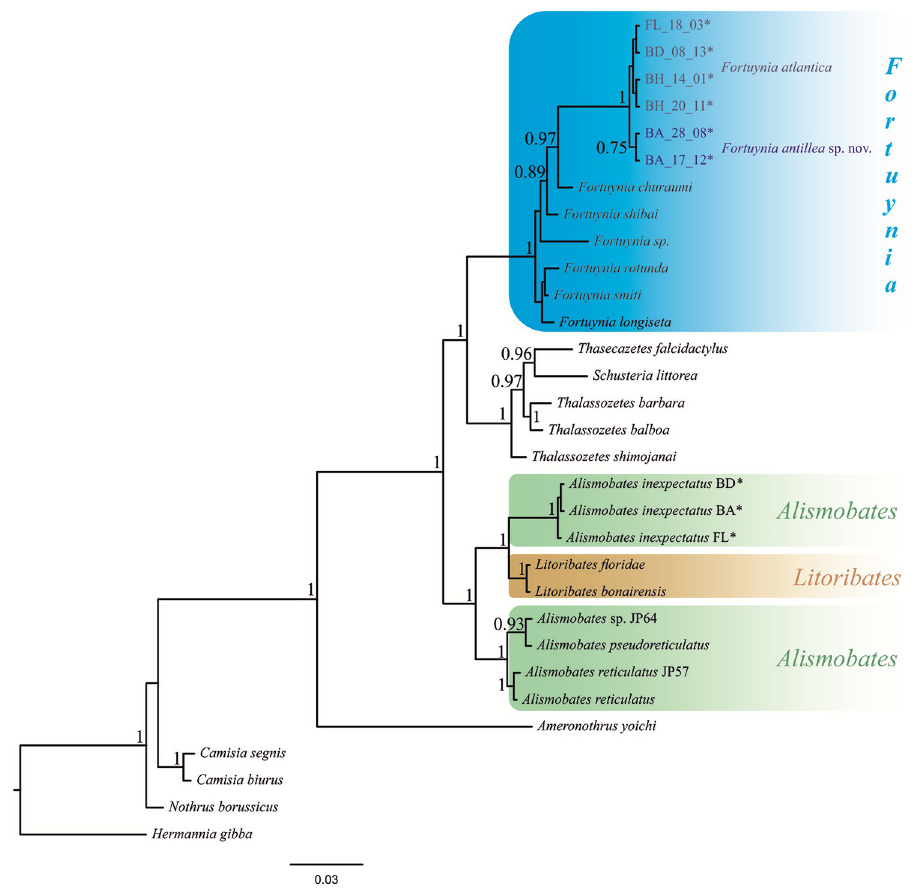
Fig 5. Bayesian inference tree based on 18S gene sequences. Fortuyniid genera are shown in different colors; � indicates sequences generated in the present study, all other sequences were obtained from GenBank.